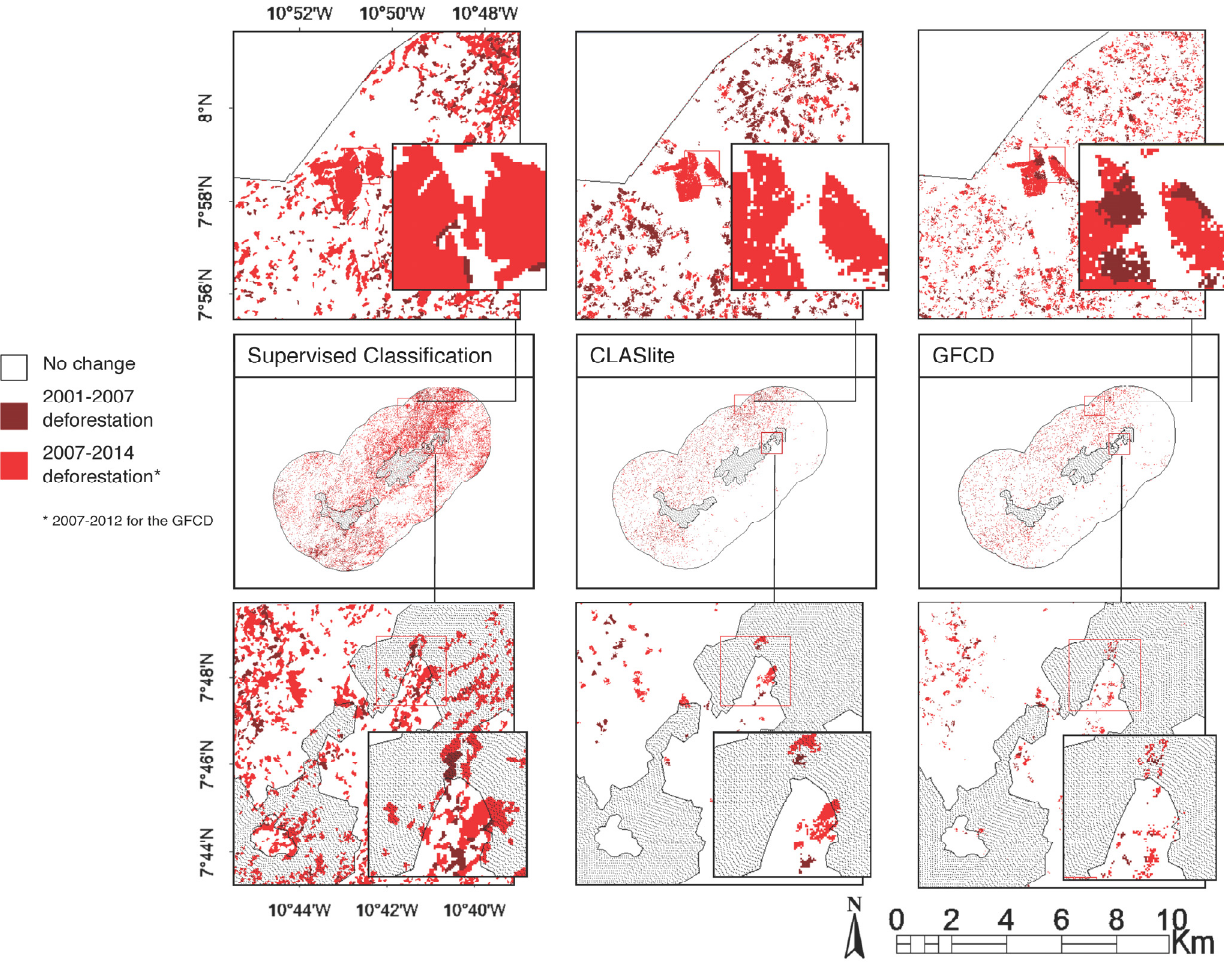
Figure 2. Forest cover-change maps of Gola and its surrounding 25 km region derived from three classification techniques and disaggregated into the time periods 2001–2007 (maroon) and 2007–2014 (red) (or 2007–2012, for the GFCD). The top row of zoomed-in panels depicts a palm plantation (the same region depicted in the top-row panels of Figure 1). The bottom row of zoomed-in panels depicts encroachment into Gola National Park. The interior region of Gola is